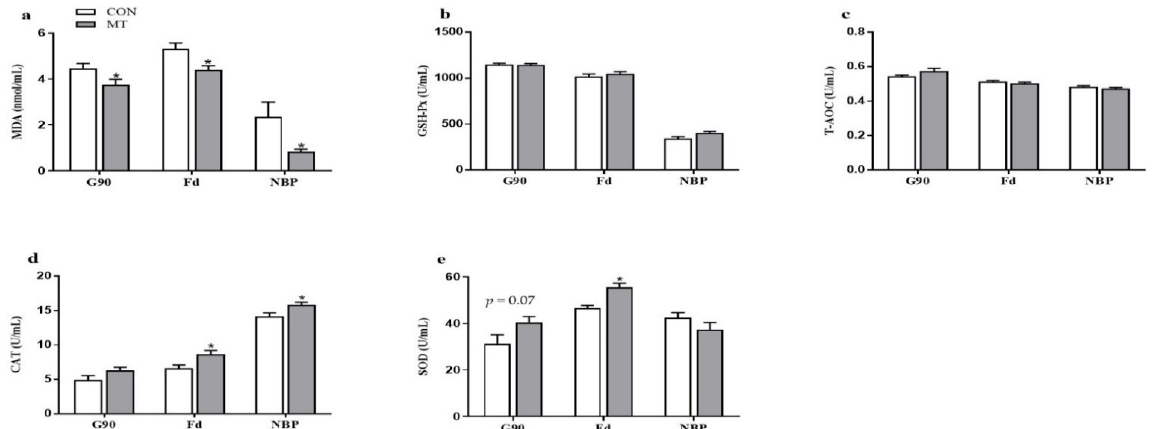
Figure 3. Effects of maternal MT supplementation during gestation on antioxidant status in serum of sows and new-born piglets. ( a ) MDA concentration, ( b ) GSH-Px activity, ( c ) T-AOC concentration, ( d ) CAT activity and ( e ) SOD activity in the serum of sows and new-born piglets. Data are presented as means ± SEM, n = 8. * p < 0.05. CON = control, MT = melatonin, G90 = d 90 of gestation, Fd = farrowing day, NBP = new-born piglets.